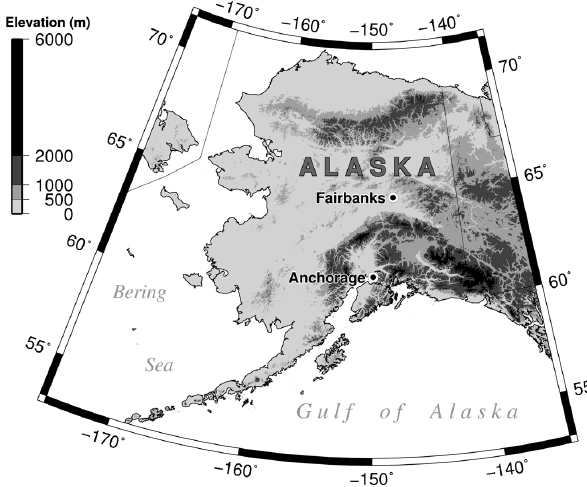
Fig. 1. Alaska showing the topographic context of Fairbanks and the Alaska Interior. Surface data were obtained at locations in Fairbanks or at the Poker Flat Research Range, 50km northeast of Fairbanks. The Alaska Mountain Range is between Fairbanks and